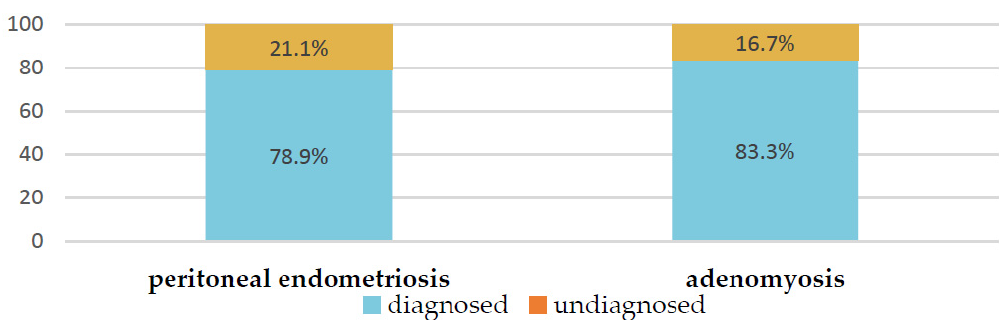
Figure 2. Frequency of suspected PE and adenomyosis according to MRI in adolescents.